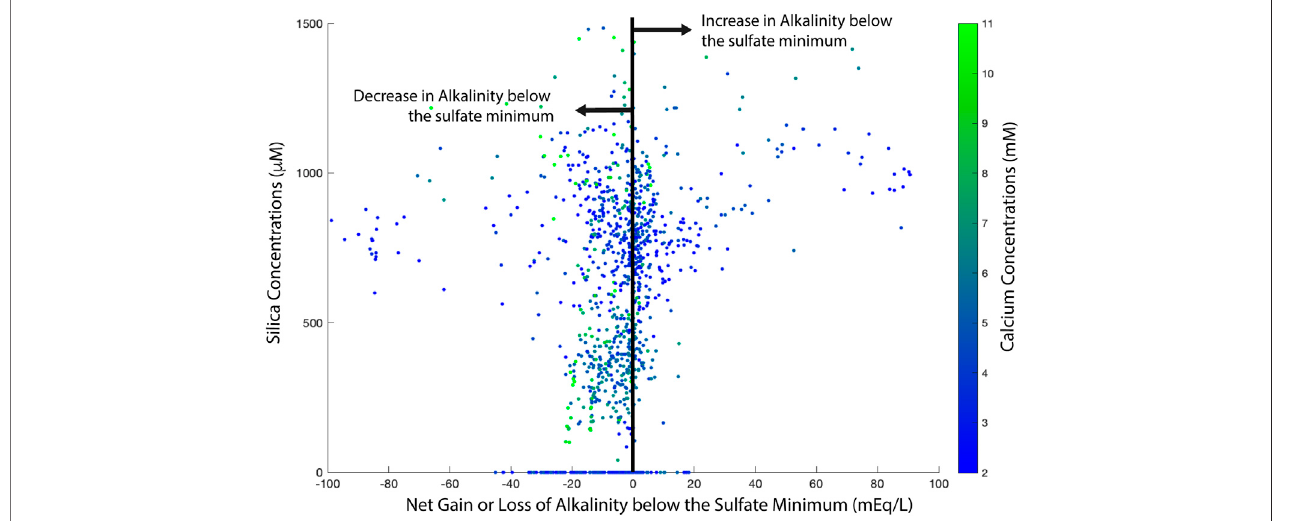
FIGURE7| Below thesulfateminimuminsediments, theamount ofalkalinitygainedorloss insedimentary pore fl uids.Datatotheright oftheblacklinesuggest an increase in alkalinity, possibly through silicate mineral weathering while data to the left of the black line suggest consumption of alkalinity below the sulfate minimum.